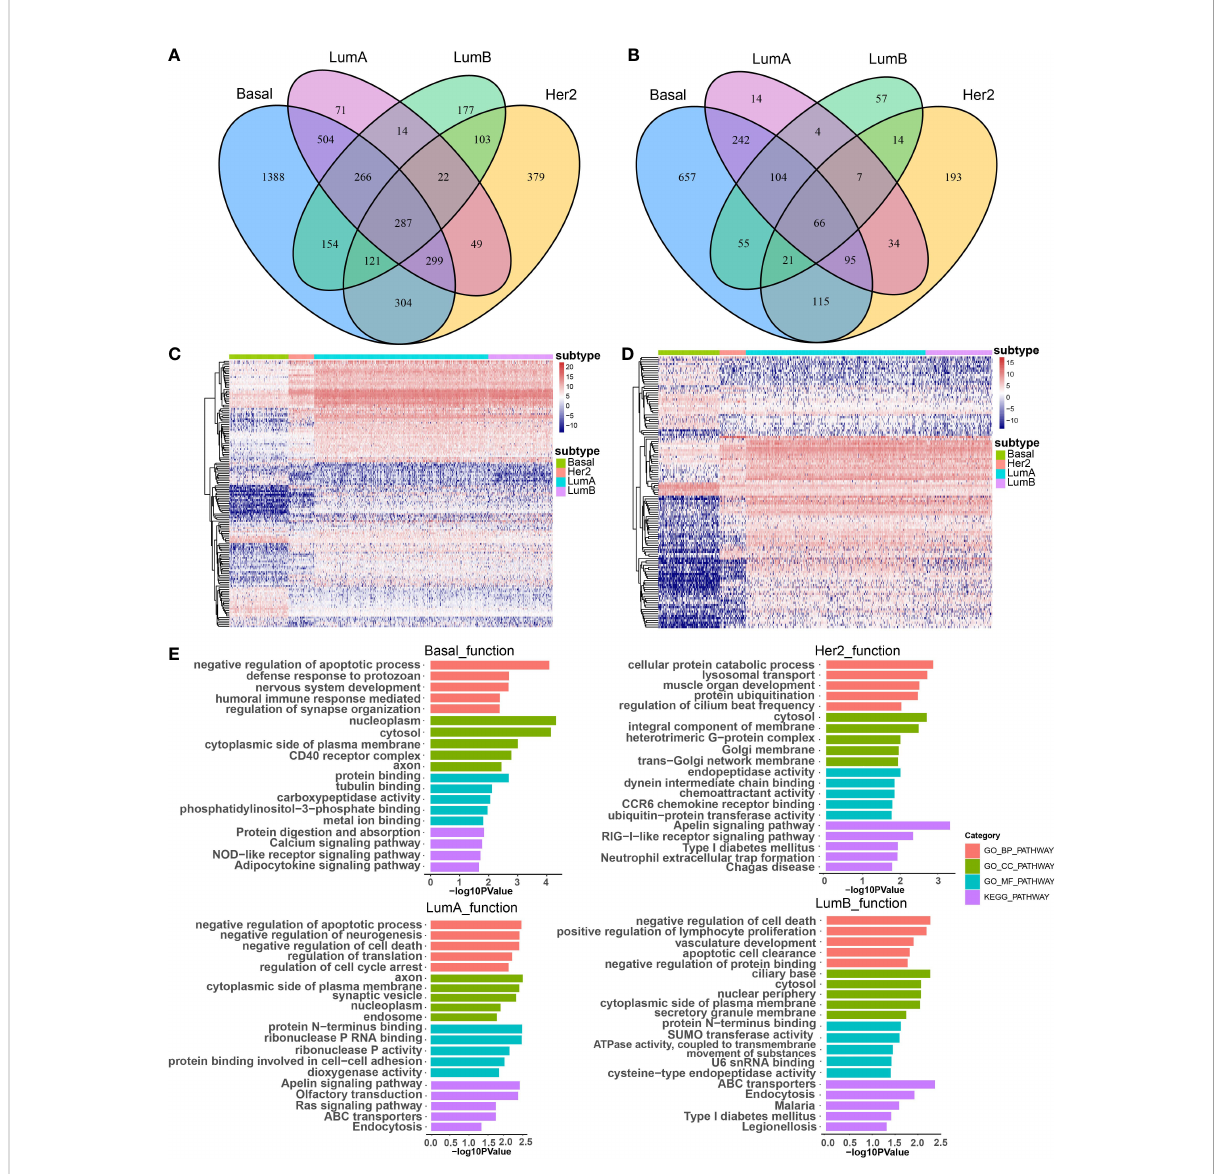
FIGURE 2 The effect of CNA-driven enhancers on expression of target genes. Venn diagram of differential genes (A) and differential lncRNAs (B) in the four subtypes. (C) Differential gene expression pro fi les of the four subtypes, and the differential gene set is the sum of the four subtype-speci fi c differential gene sets. (D) Differential lncRNA expression pro fi les of the four subtypes, and the differential lncRNA set is the sum of the four subtype-speci fi c differential lncRNA sets. (E) The top-ranked terms of GO function and KEGG pathway for differentially expressed genes in Basal-like, her2, LumA and LumB subtypes using